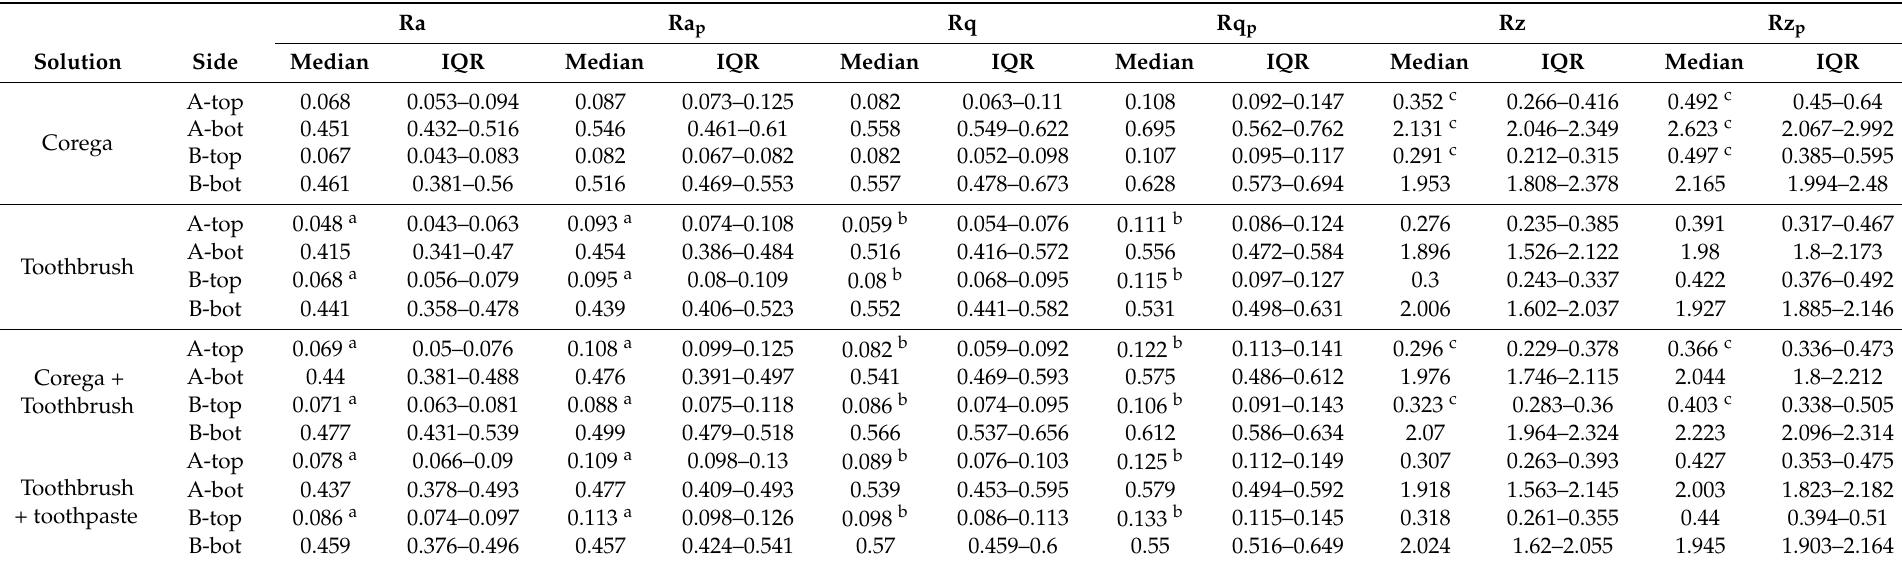
Table 1. Descriptive statistics of surface roughness parameters before (Ra, Rq and Rz) and after cleaning protocol (Ra p , Rq p and Rz p